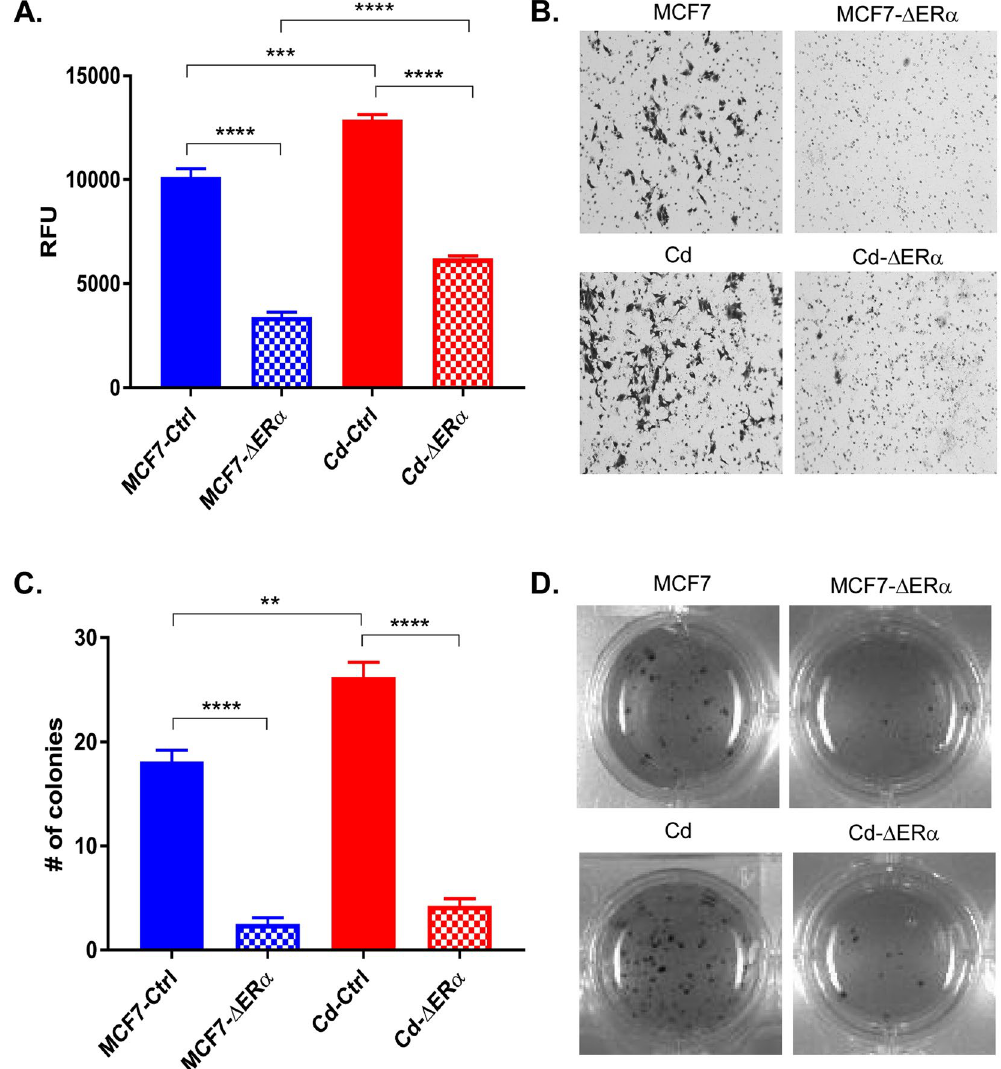
Figure 2. Cadmium-adapted cells are more invasive and tumorigenic than parental MCF7 cells. ( A ) Approximately 5 × 10 4 cells were seeded into cell invasion chambers in triplicate and incubated for 24 hours. Invasive cells were measured using a fluorescent plate reader, and the data was collected from three independent experiments and shown as mean with SEM ( n = 9, 27, 18, 45, left to right). Statistical analysis was performed using a two-tailed T test ( *** p < 0.001; **** p < 0.0001). ( B ) Representative images of invasive MCF7-Ctrl, MCF7- Δ ER α , Cd-Ctrl (MCF7-Cd), and Cd- Δ ER α cells stained with crystal violet. The results are representative of three independent experiments. ( C ) Anchorage-independent growth was measured using the colony formation assay in soft agar. Only colonies with approximately 100 cells or more were counted, and the results represent three independent experiments of triplicate samples shown as mean with SEM ( n = 9, 27, 18, 45, left to right). Statistical analysis was performed using a two-tailed T test ( ** p < 0.01; **** p < 0.0001). ( D ) Representative images of MCF7, MCF7- Δ ER α , Cd, and Cd- Δ ER α colonies growing in soft